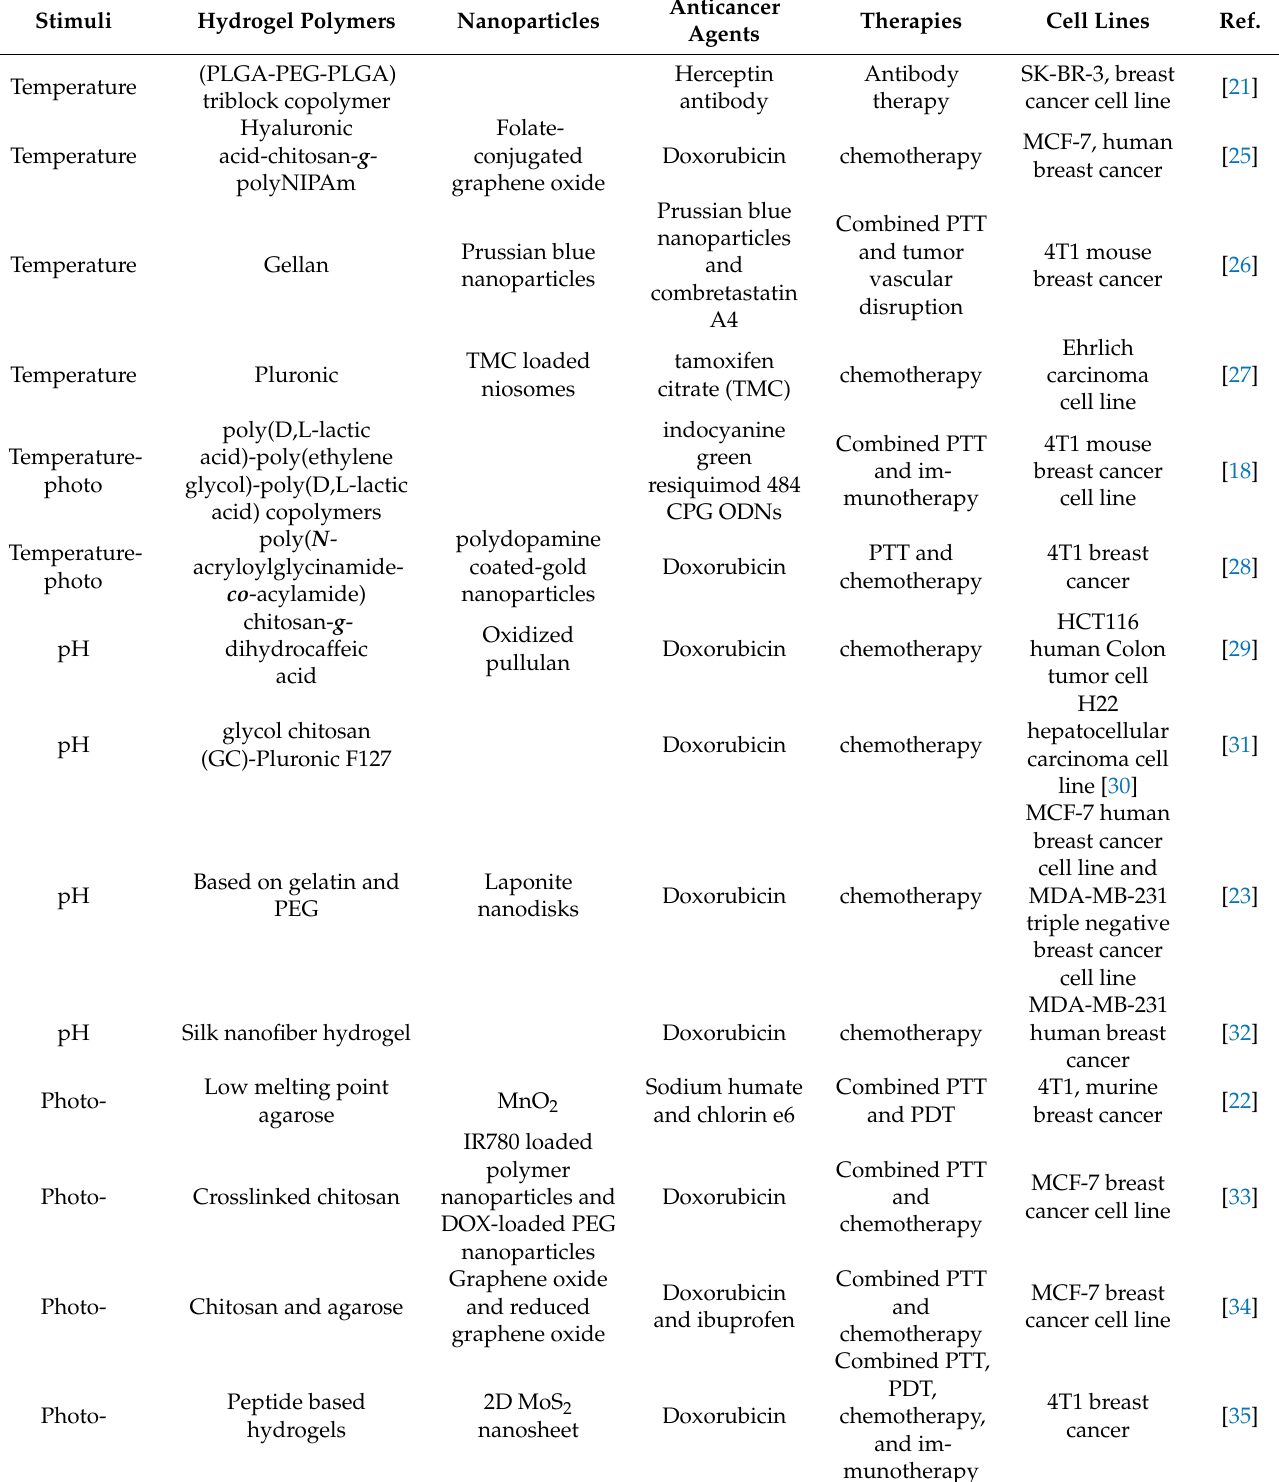
Table 1. Stimuli-responsive injectable hydrogel drug delivery systems reported for breast cancer therapies. Multiple therapies can be embraced into one hydrogel system, including photothermal therapy (PTT), photodynamic therapy (PDT), immunotherapy, and